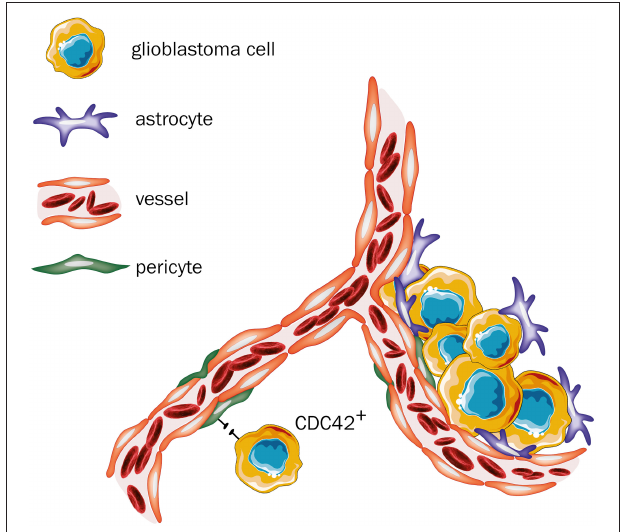
FIGURE 5 | Glioblastoma—primary tumor. Once cancer cells reach the blood vessels, two outcomes are feasible: (i) neoplastic cells produce flectopodia and fuse with pericytes through CDC42-mediated processes to produce hybrid cell types. However, when CDC42 activity is blocked, fusion is abrogated, and pericytes might gain anti-tumor activities (assuming a peripheral-derived macrophage-like phenotype). (ii) tumor cells place themselves between astrocytes and pericytes, thereby blocking their physiological interactions and changing their normal functions (Figure created with vectors from Servier Medical Art. https://smart.servier.com/).